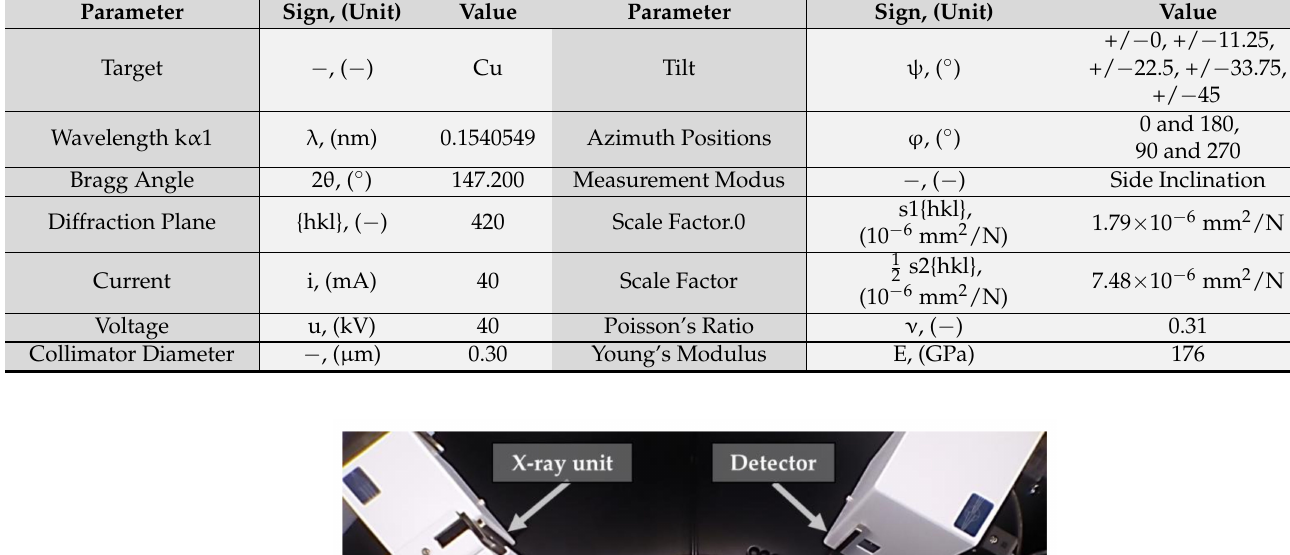
Table 3. Measurement parameters of the residual stress measurements and analysis.